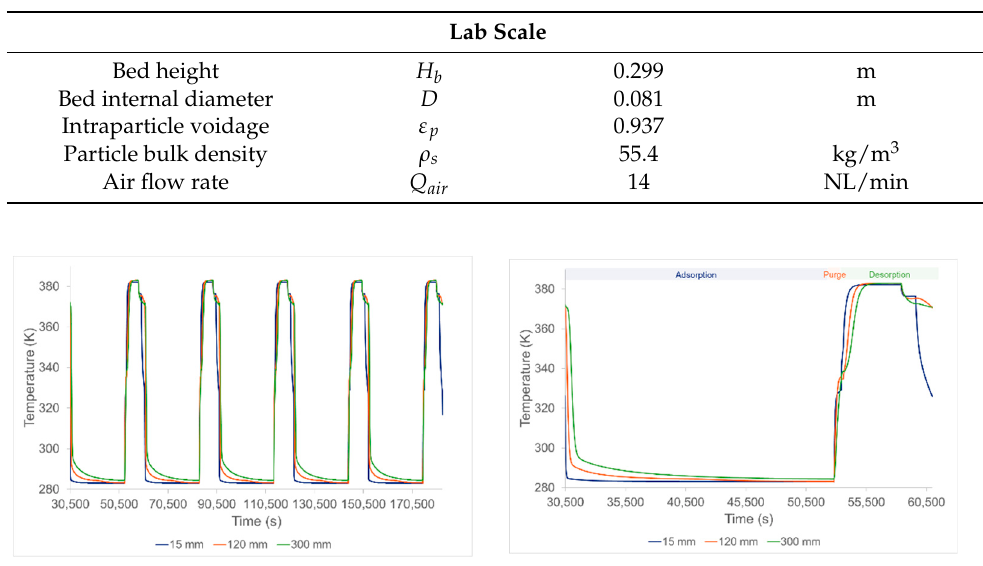
Table 4. Lab-scale bed characteristics.